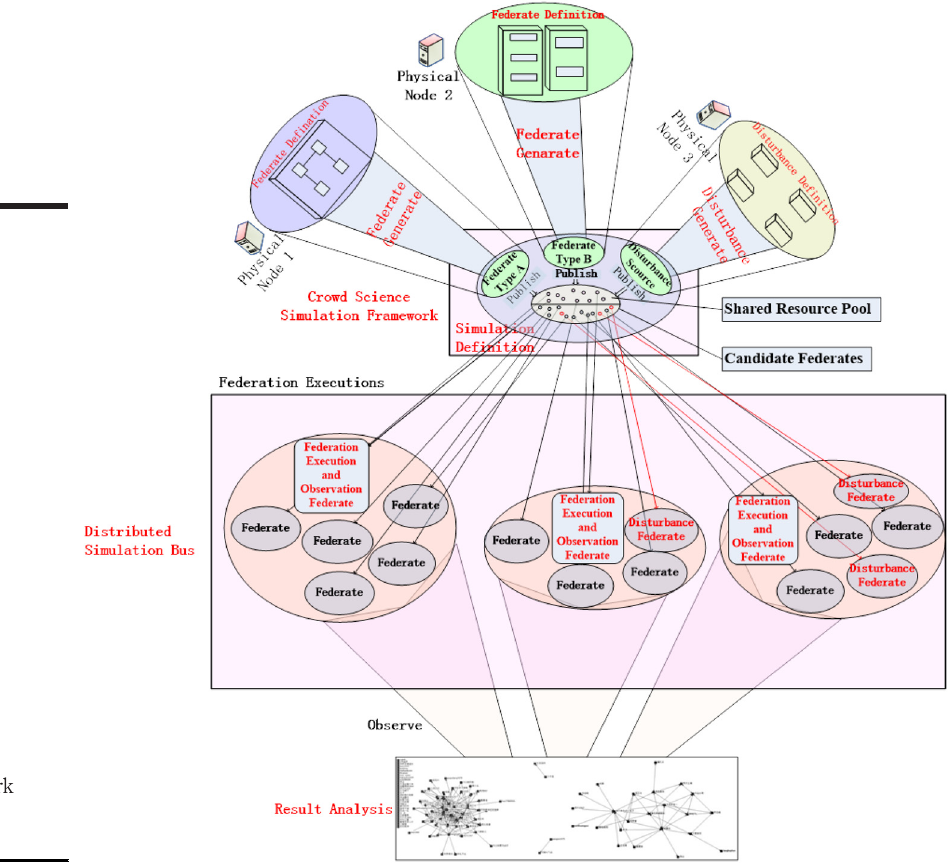
Figure 1. Crowd network simulation